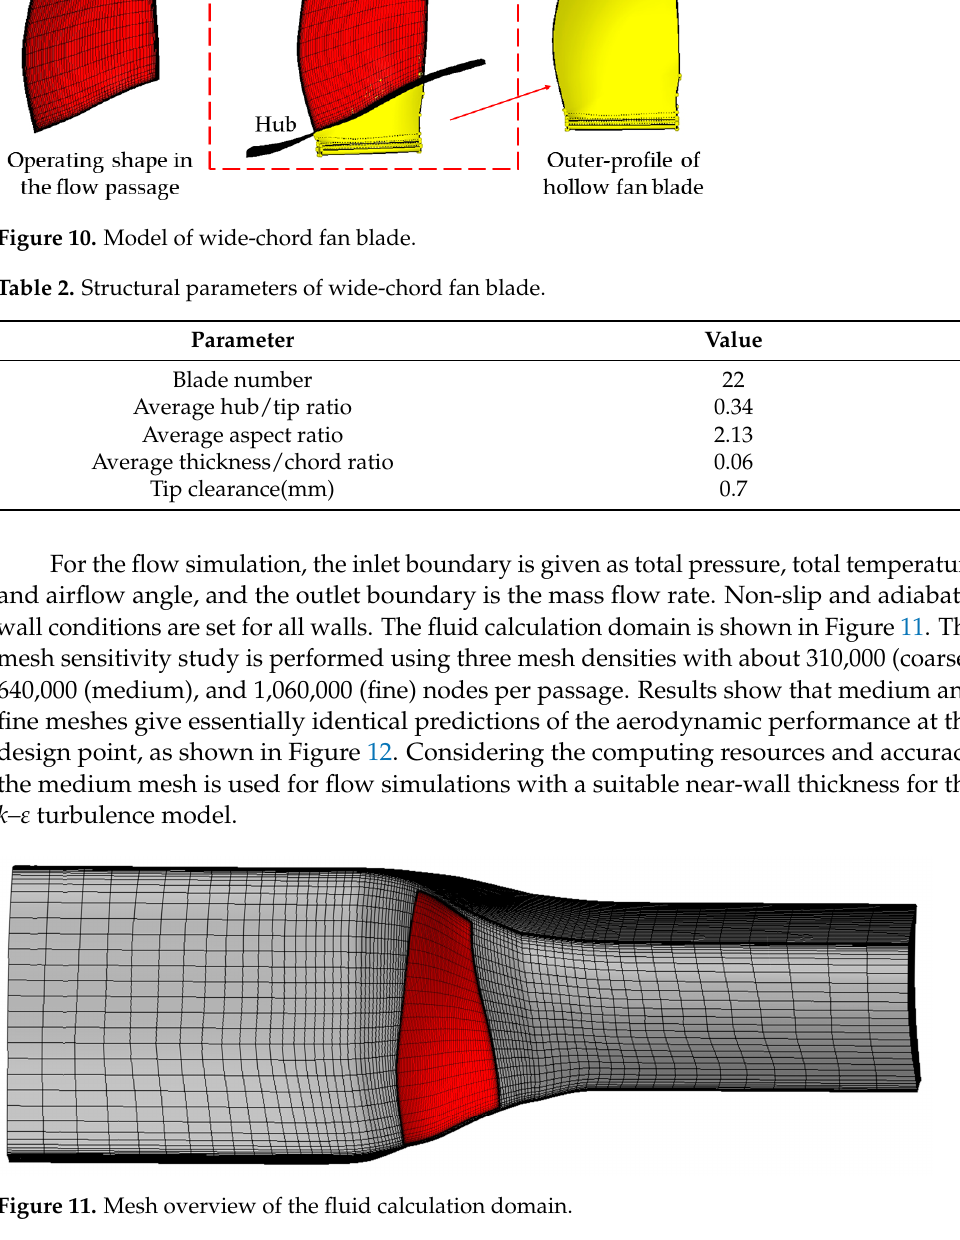
Figure 12. Aerodynamic performance of three mesh densities. 4. Results and Discussions The results and discussions of the wide-chord fan blade model in Section 3 are pre- sented below. A typical hollow structure is generated according to the parametric model- ing method of the hollow fan blade given in Sections 2.1 and 2.2. Based on this hollow fan blade, the differences between the four hot-to-cold methods (proposed in Section 2.3) are compared, and the reasons for the differences are discussed.